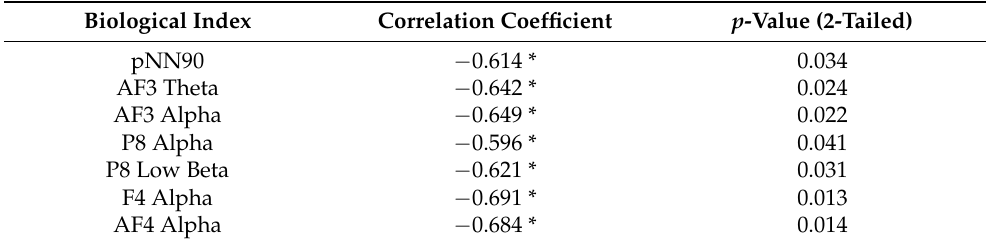
Table 13. Correlation coefficients between the number of errors in Task2 and the mean values